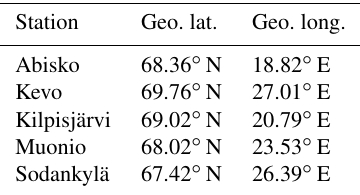
Table 1. Locations (geographic latitude and longitude) of the cam- era stations used in this work. Station Geo. lat. Geo.